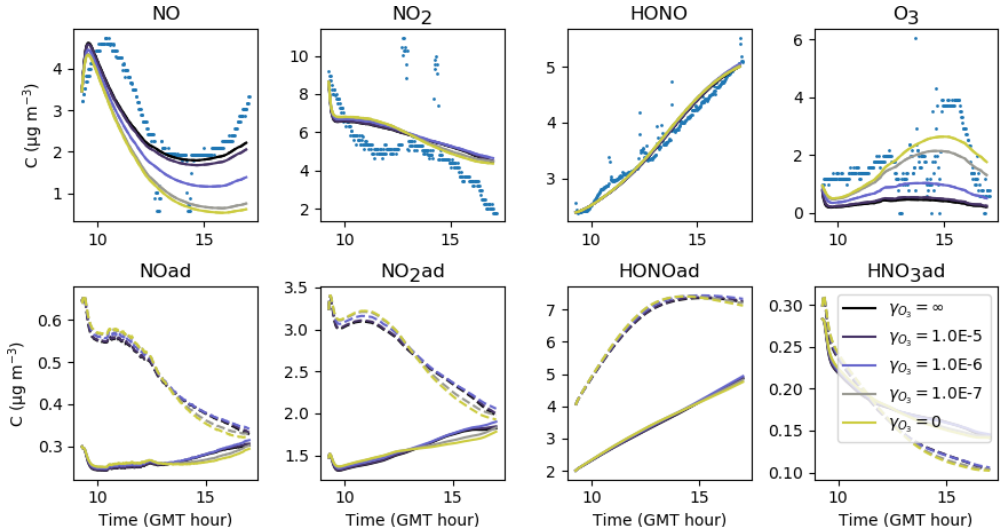
Figure 22. Gas-phase and adsorbed inorganic compounds simulated for different γ O (Experiment 3). The solid lines represent the concentrations in the sunlit box and the dashed lines the concentrations in the shaded